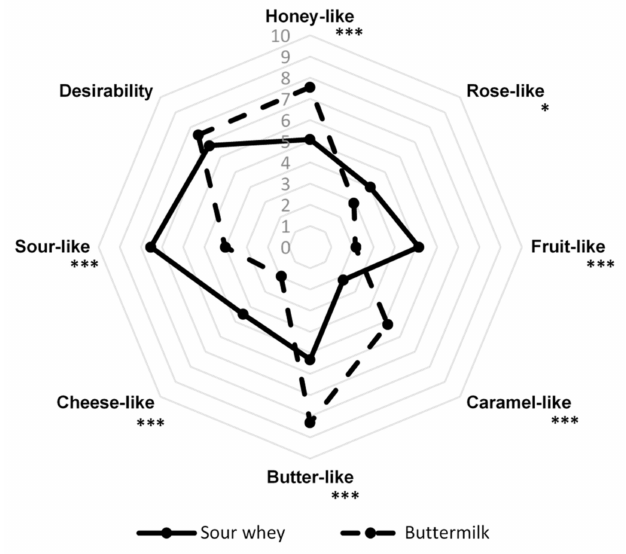
Figure 5. Sensory profiles of post-fermentation products from flack cultures with sour whey and buttermilk. * p < 0.05; *** p <